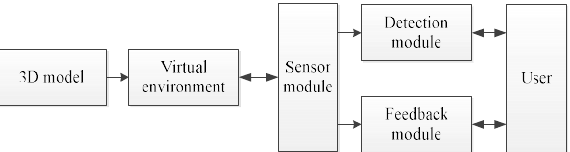
Figure 1. The composition of the virtual reality